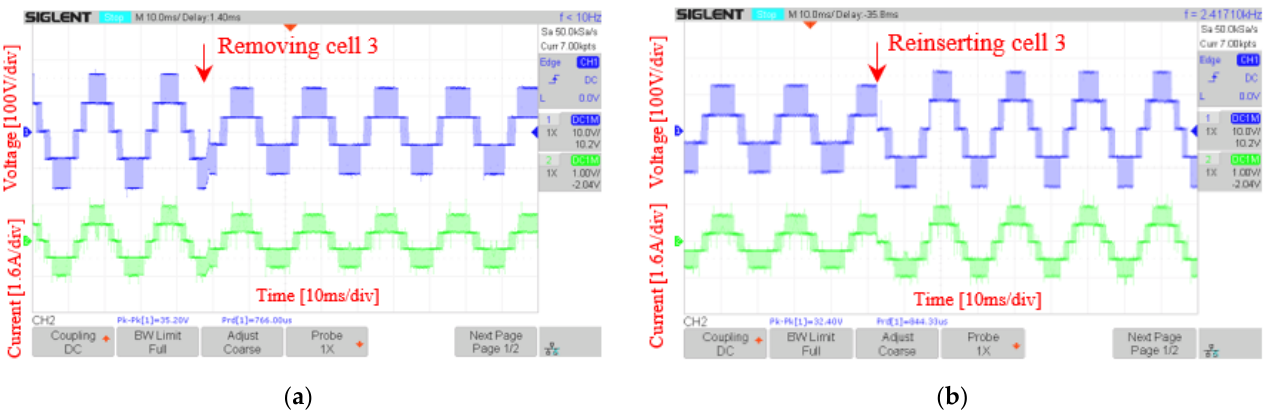
Figure 45. Output voltage and load current when removing and reinserting cell 3 using DSA-LSC method, ( a ) removing cell 3; ( b ) reinserting cell 3.